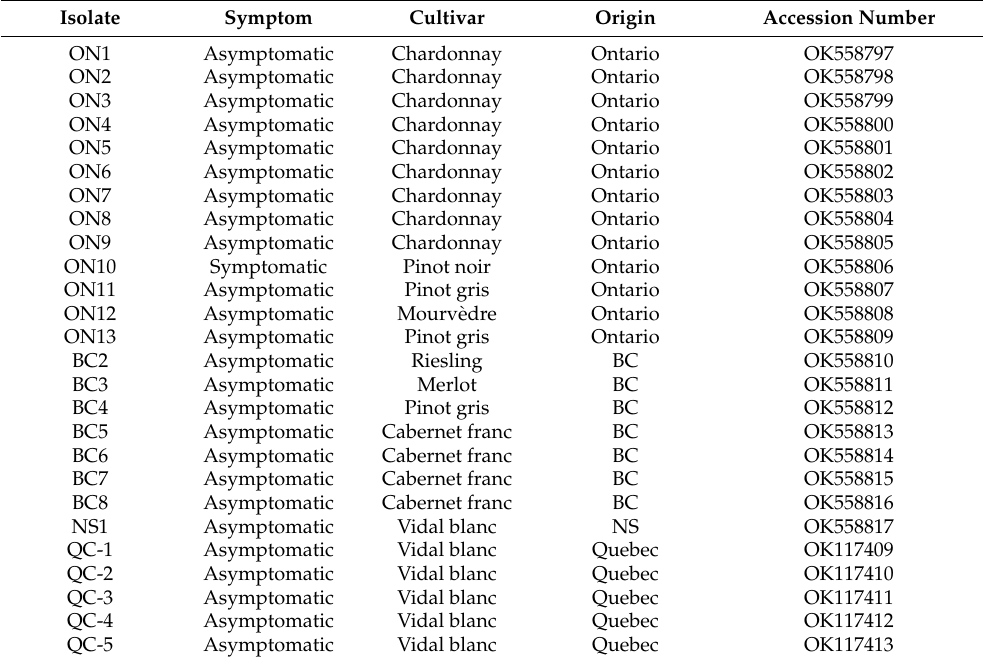
Table 2. Information on the cultivars, symptoms, origins and accession numbers of 21 GPGV isolates sequenced in this study and the five assembled genomes of GPGV provided by Dr. Fall’s lab at AAFC Saint-Jean-sur-Richelieu